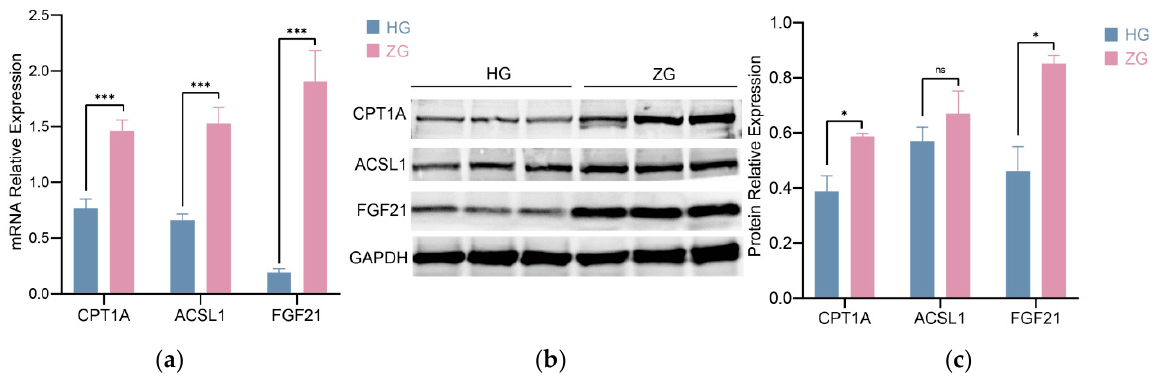
Figure 6. The relative expressions of CPT1A , ACSL1, and FGF21 in Hu sheep and Tibetan sheep livers via qRT-PCR ( a ) and Western blot analysis ( b , c ). HG is representative of the Hu sheep livers. ZG is representative of Tibetan sheep livers. The data in ( a , c ) are presented as the mean ± SD, n = 3 biologically independent samples; the significant differences (n.s. p > 0.05; * p < 0.05; *** p < 0.001) were performed using two-tailed unpaired t -test.